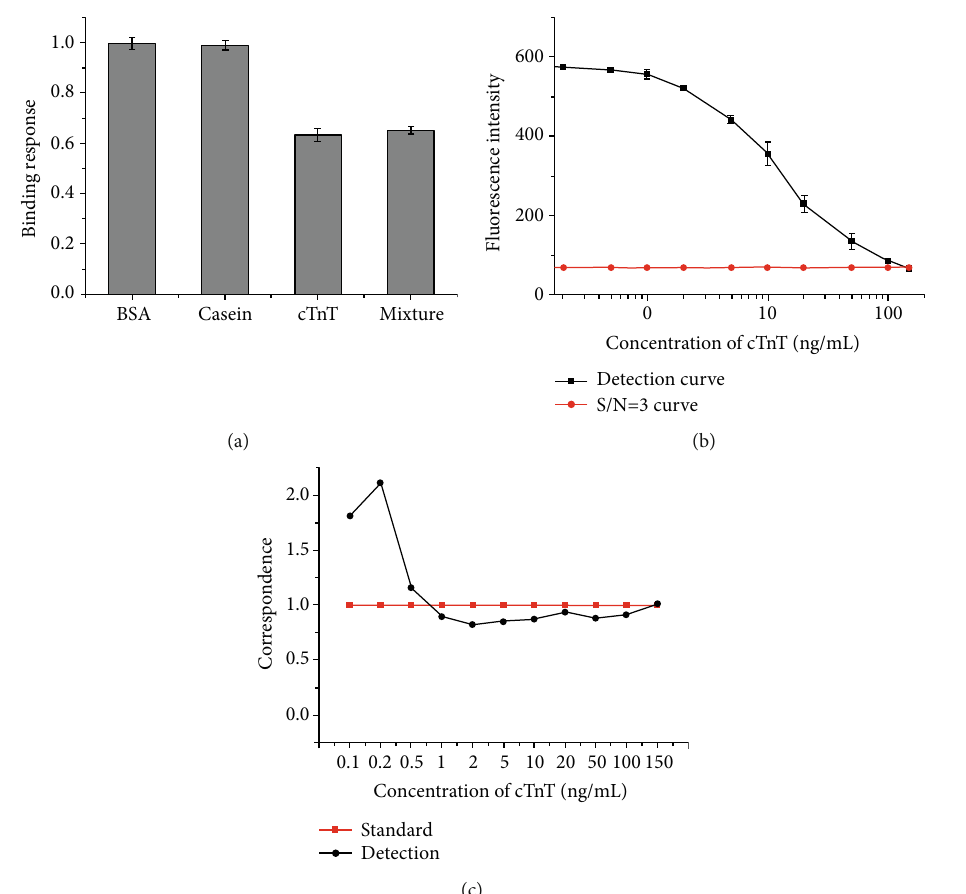
Figure 5: (a) Binding response histogram of di ff erent matrix resolutions (BSA, casein, a mixture, and cTnT). (b) A curve of fl uorescence intensity of di ff erent concentrations of cTnT and a signal-to-noise ratio ( S/N = 3 ) curve. (c) Detection correspondence and standard correspondence curves against di ff erent concentrations of